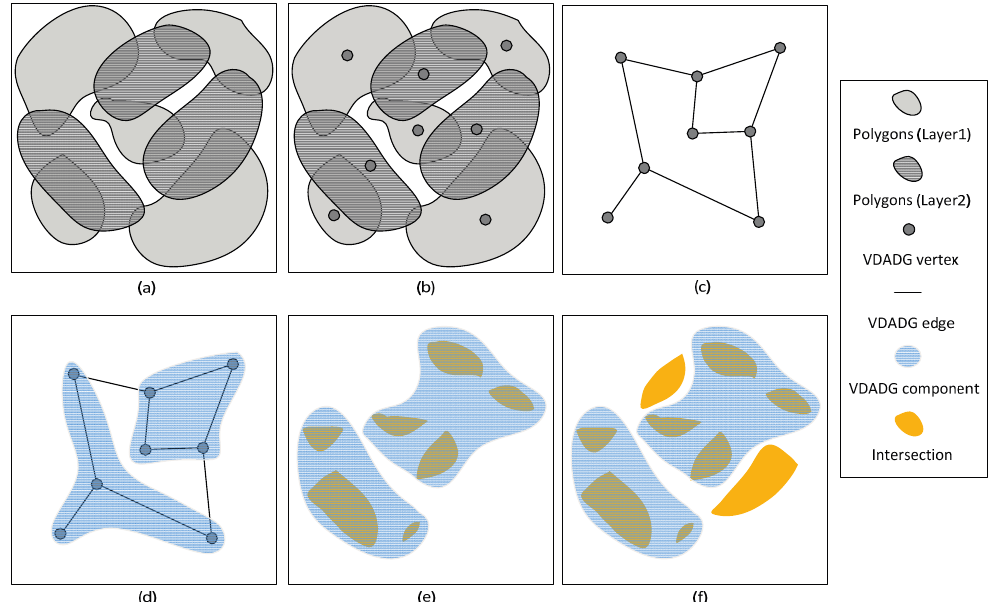
Figure 7. Parallelization of intersection operation. ( a ) Two layers of polygons; ( b ) Representation of the SDDG vertices; ( c ) The SDDG for the intersection operation; ( d ) Partitioning of the SDDG; ( e ) Performing the two subtasks in parallel; ( f ) Handling the inter component